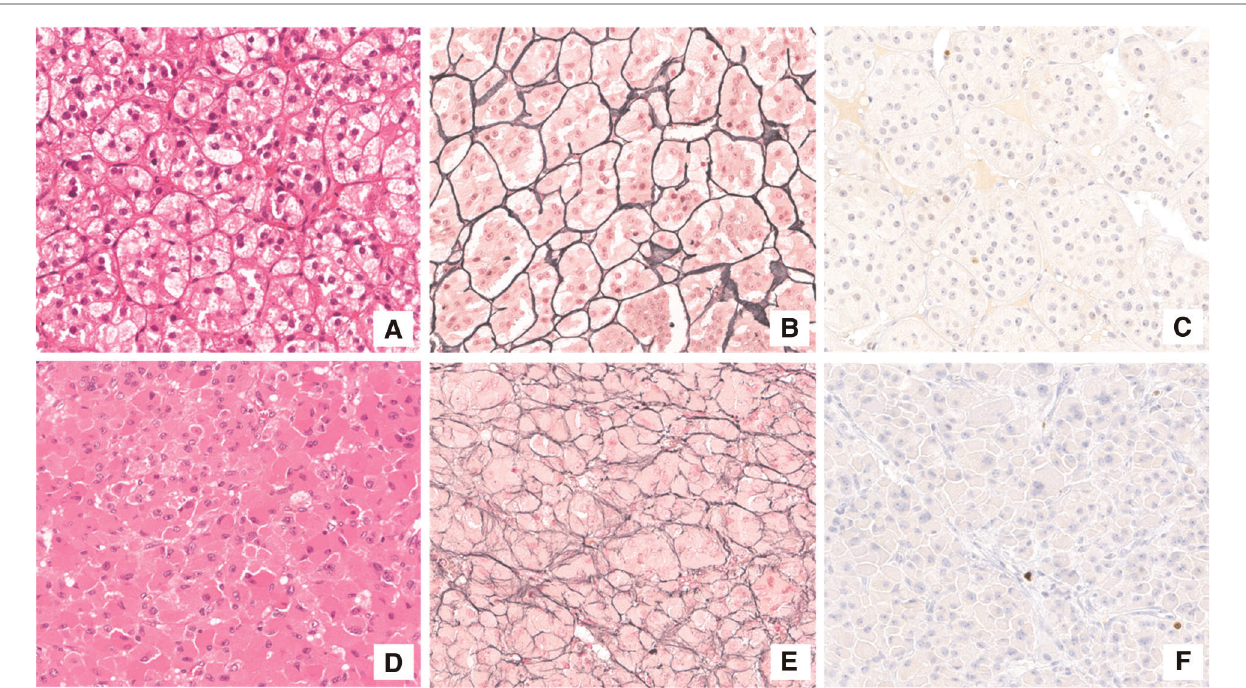
FIGURE 4 | Histological assessment. Adrenocortical adenoma ( A – C ). The neoplasm was mainly composed of lipid-laden cells resembling those of normal zona fasciculata ( A ). The reticulin framework completely surrounded adrenal adenoma cells in small nests ( B ). Proliferation index (Ki-67) was lower than 1% ( C ). Adrenocortical oncocytoma ( D – F ). Oncocytic cells were characterized by granular eosinophilic cytoplasm and bland-appearing nuclei ( D ). The solid-alveolar pattern was better appreciated with reticulin stain ( E ). Ki-67 immunostaining labeled a very low number of neoplastic cells ( F